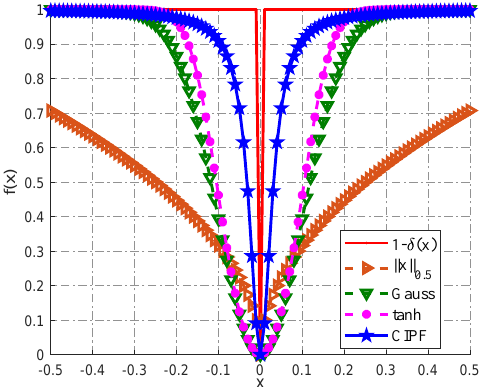
Figure 2. Different functions used in the literature to approximate the L 0 -norm; some of them are plotted in this figure, and the L 0.5 -norm is displayed for comparison. CIPF, compound inverse proportional